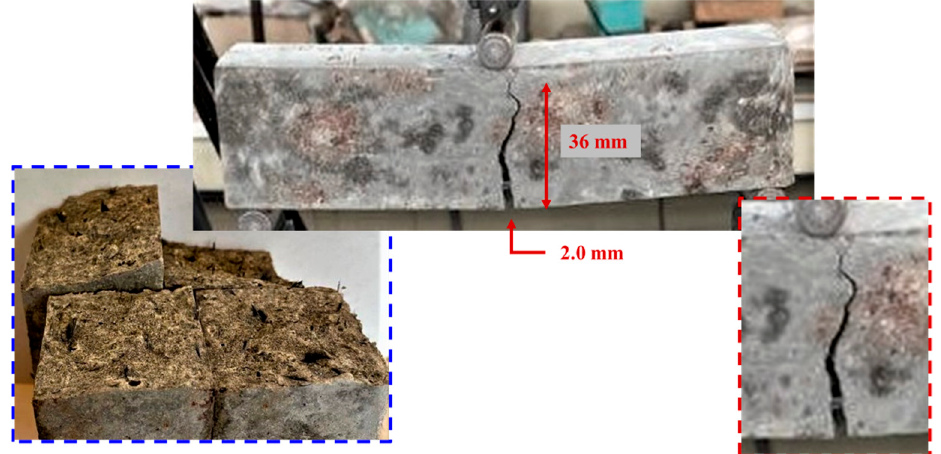
Figure 13. Crack width and length after bending test and CFs concentration at the rupture interface in the case of wet mixing of CFs adding Carboxymethyl Nanocrystal (CMC).